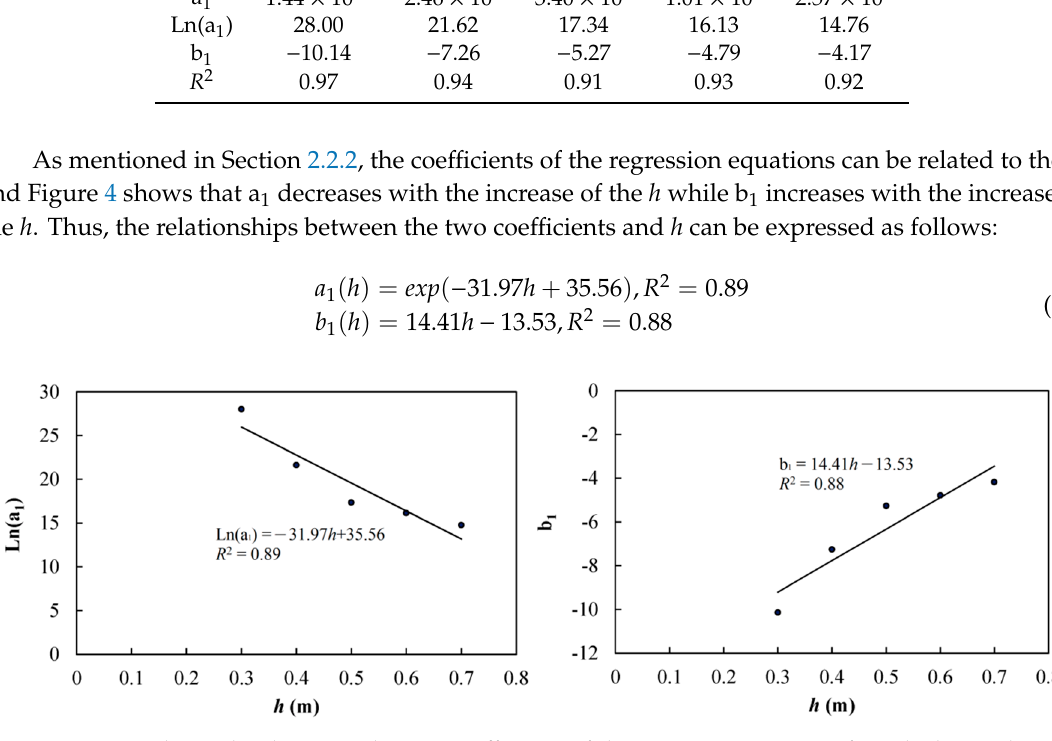
Table 2. The coe ffi cients of the regression equations for calculating the residence time ( RT ) under the five modeling scenarios with di ff erent heights of the weir ( h ), and their R 2 values. h (m) h = 0.3